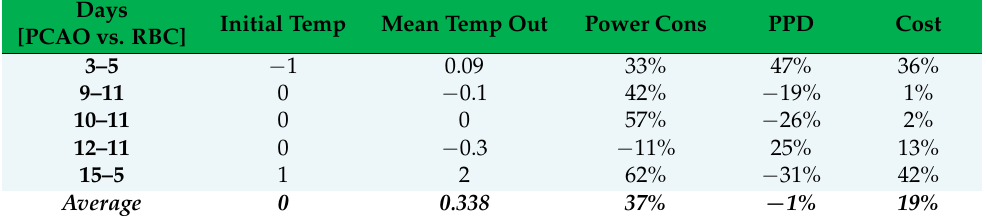
Table 10. Overall aggregated comparison results (summer).